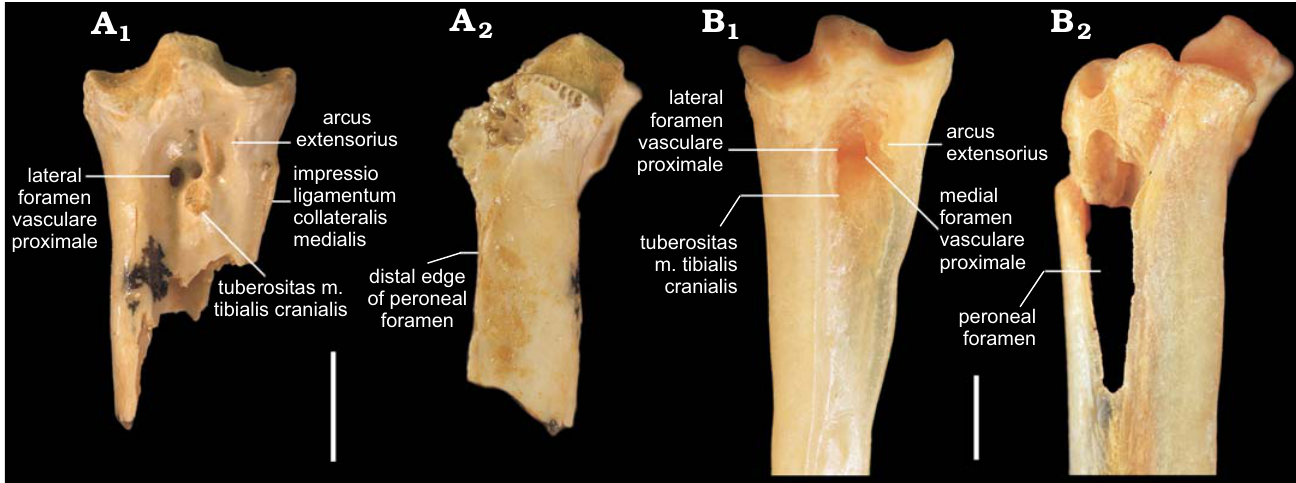
Fig. 2. Proximal right tarsometatarsus of the quail-thrush bird Cinclosoma sp., QM F57969 from the middle Miocene Rick’s Sausage Site, Riversleigh World Heritage Area, Australia ( A ), compared with a proximal left tarsometatarsus (mirrored) of the Recent Cinclosoma punctatum (Shaw, 1794), NMV B.12648 ( B ); in dorsal (A 1 , B 1 ) and lateral (A 2 , B 2 ) views. Note that the arcus extensorius is broken in NMV B.12648. Scale bars 2 about level, of the distal-most point of the crista bicipitalis. It differs additionally from C. castanotum in having a shal- lower fossa ventrally of the margo caudalis.